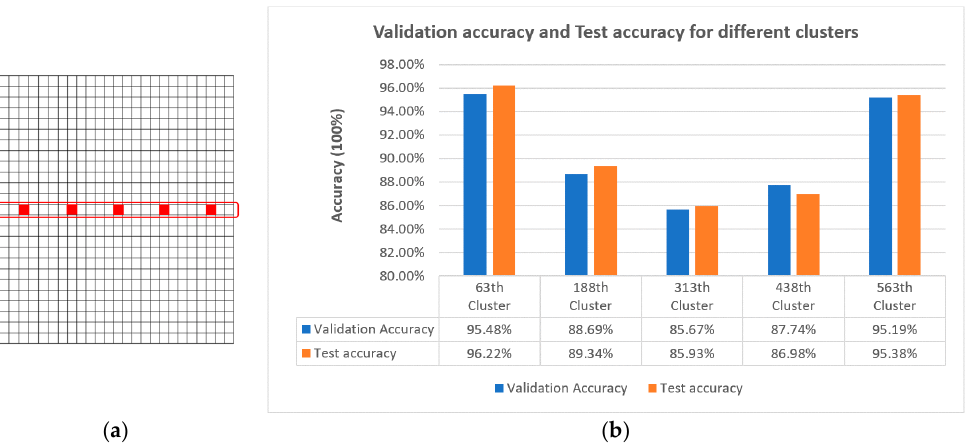
Figure 7. ( a ) Cluster grid and the selected clusters (marked with red squares). ( b ) Comparison of the selected clusters for validation and test accuracy.